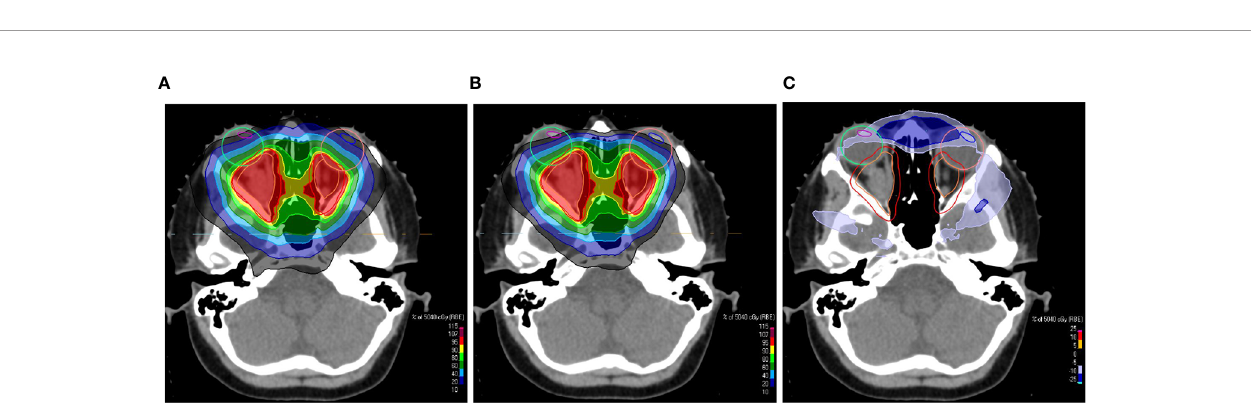
FIGURE 6 | Transversal CT slices overlaid with a colorwash representation of the dose distribution of the uncollimated plan (A) and the plan with apertures (B) for the treatment of an opticus glioma. The screenshots of the treatment planning in RayStation show the dose sparing of the eye lenses, which are indicated by the blue and magenta contours. (C) shows the dose difference between the plans. The beams eye view of one of the treatment fi elds is shown in Figure 1